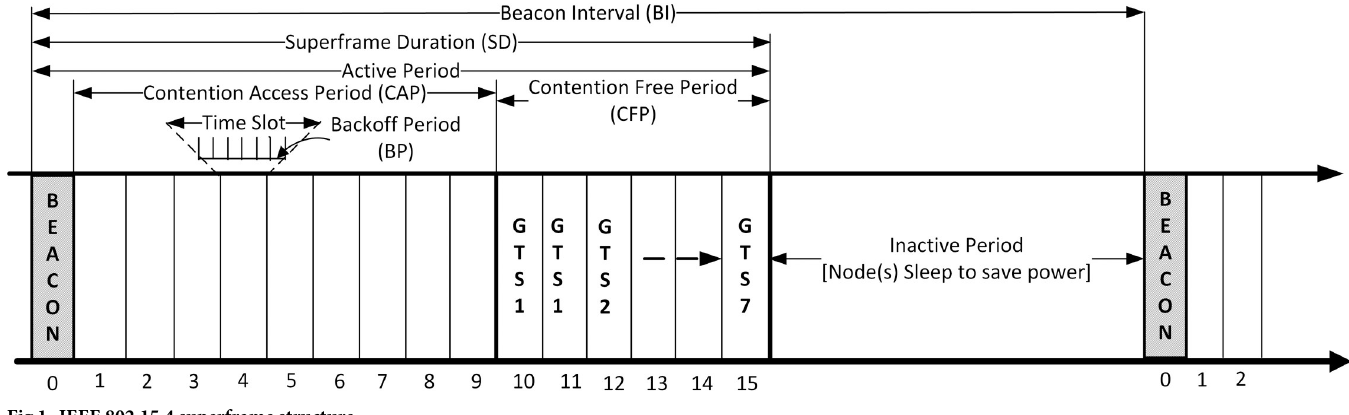
Fig 1. IEEE 802.15.4 superframe